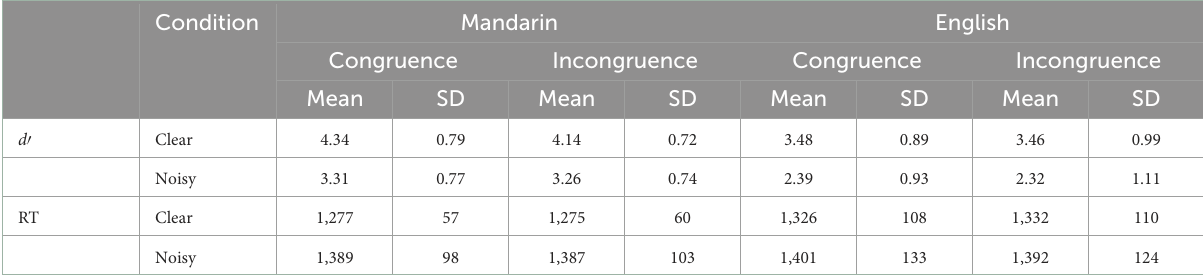
TABLE 2 The mean d’ and RT (in ms) of the lexical tone task for Mandarin ( N = 21) and English speakers ( N = 32). Condition